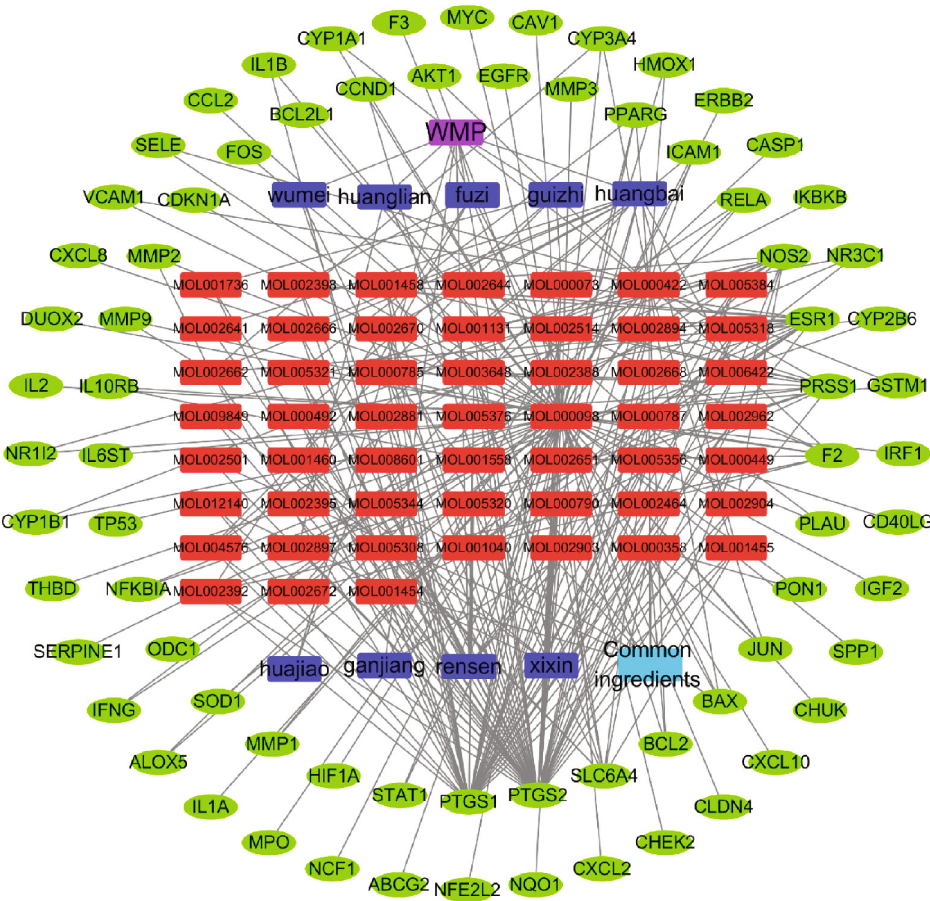
Figure 3: Drug-ingredient-target gene network of WMP.